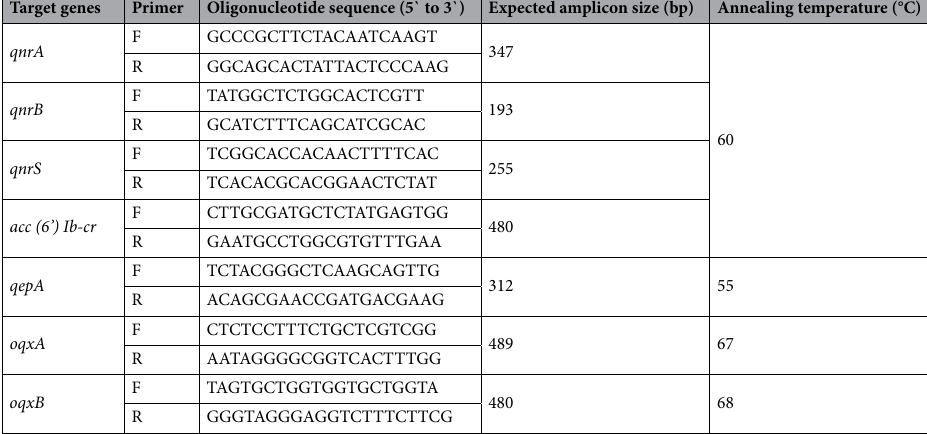
C. Sequencing of resulting amplicons of target genes PCR amplicons of target genes: qnrA, qnrB, qnrS, aac(6 ′ )-Ib-cr, qepA, oqxA , and oqxB resulting from plasmid extracts of test isolates from selected profiles numbers 1, 2, and 3 only were sequenced using Sanger sequencing technique (Applied Biosystems genetic analyzers (ThermoFisher, UK)). Such kind of isolates might be more life-threatening ones.